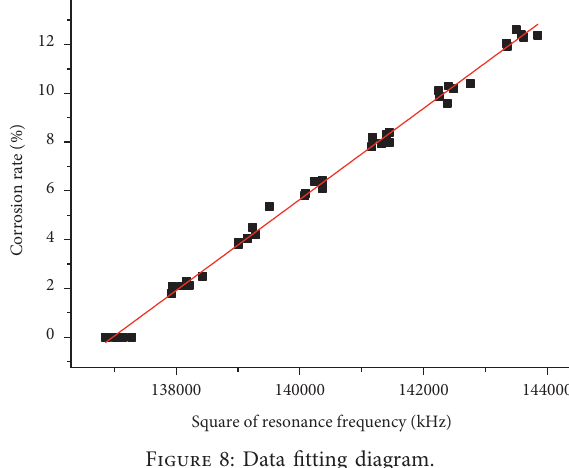
Figure 8: Data fitting diagram.